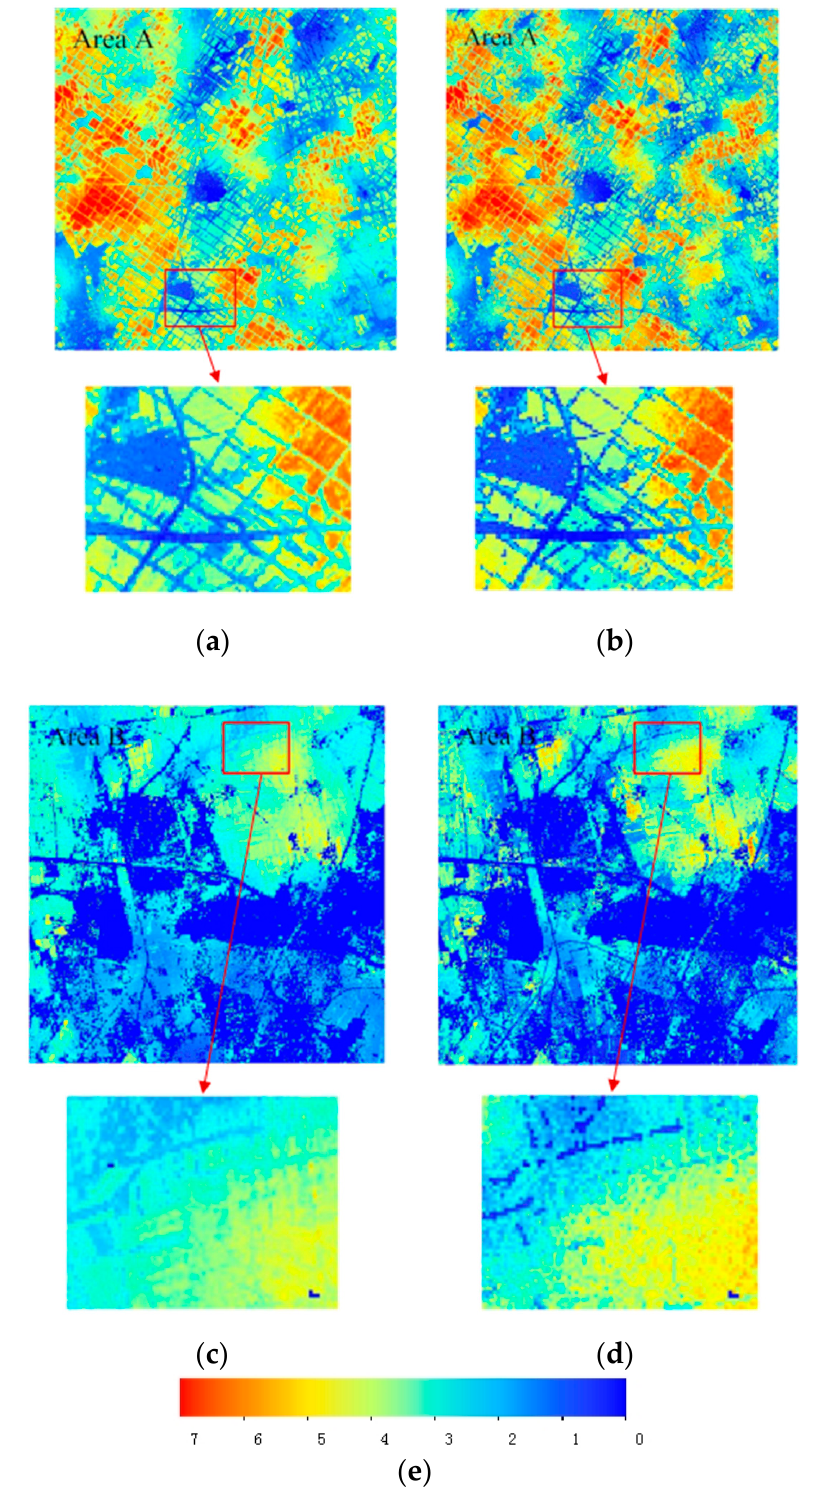
Figure 3. Comparison of 30 m LAI on August 5 generated by the improved FSDAF model and the FSDAF method: ( a , c ) LAI predicted by the improved FSDAF; ( b , d ) LAI generated from the FSDAF model; ( e ) the legend of the maps.